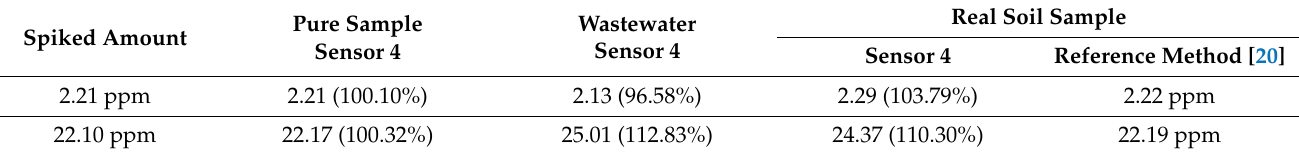
Table 4. Application of sensor (in Tris buffer) for determination of 2,4-D in pure water sample, wastewater sample, and soil sample, with recovery values and values obtained by the reference method [20] for real